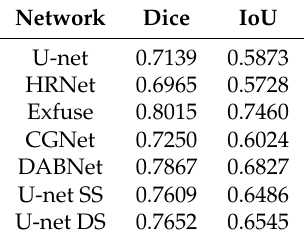
Table 3. Results on the test dataset in Dice and Intersection over Union (IoU) scores of each